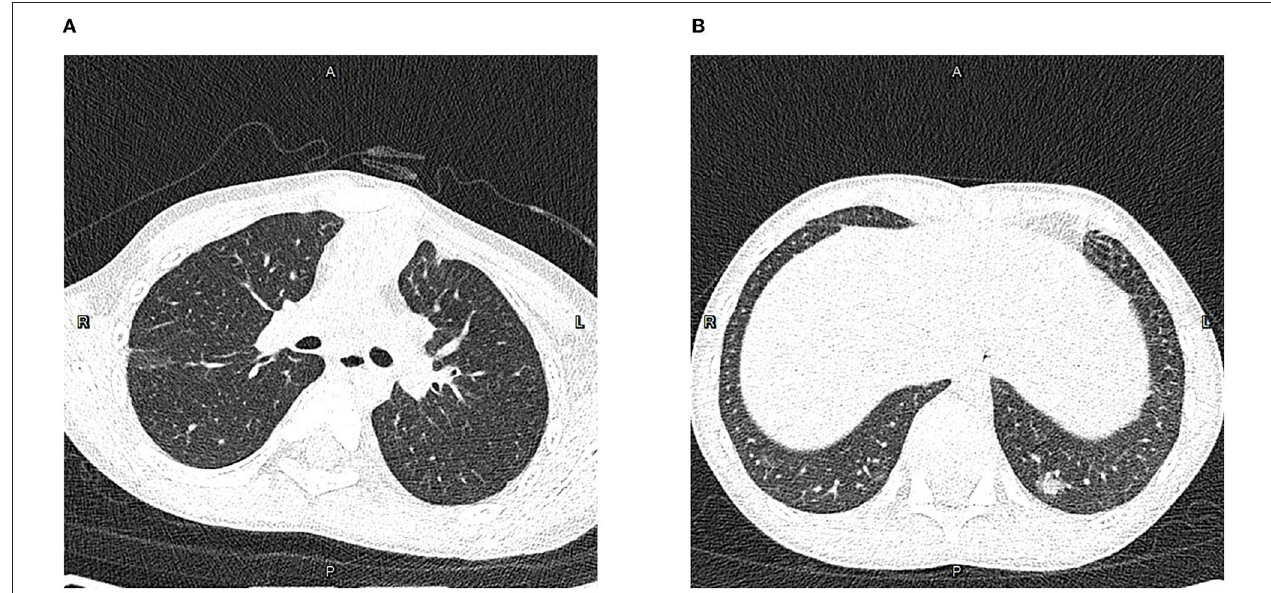
FIGURE 2 | Computed tomography of the chest in the axial plane. (A) On hospital Day (HD) 1, showing slight inflammation in the middle lobe of the right lung and upper lobe of the left lung. (B) On HD 7, showing little emerging flaky exudation in the posterior basal segment of the left lower lobe.